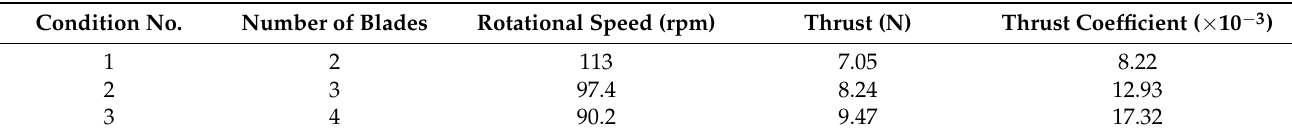
Table 4. The thrust and thrust coefficient with various numbers of blades.